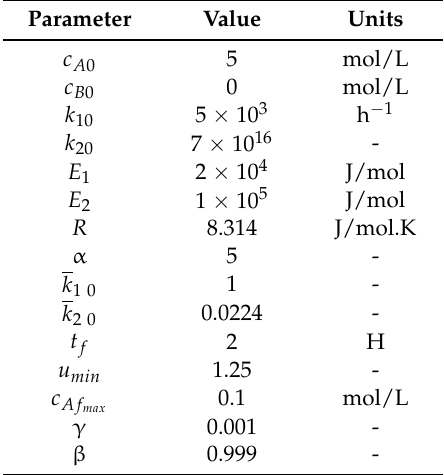
Table 1. Models parameters, operating bounds, and initial conditions for Cases 1 to 6.